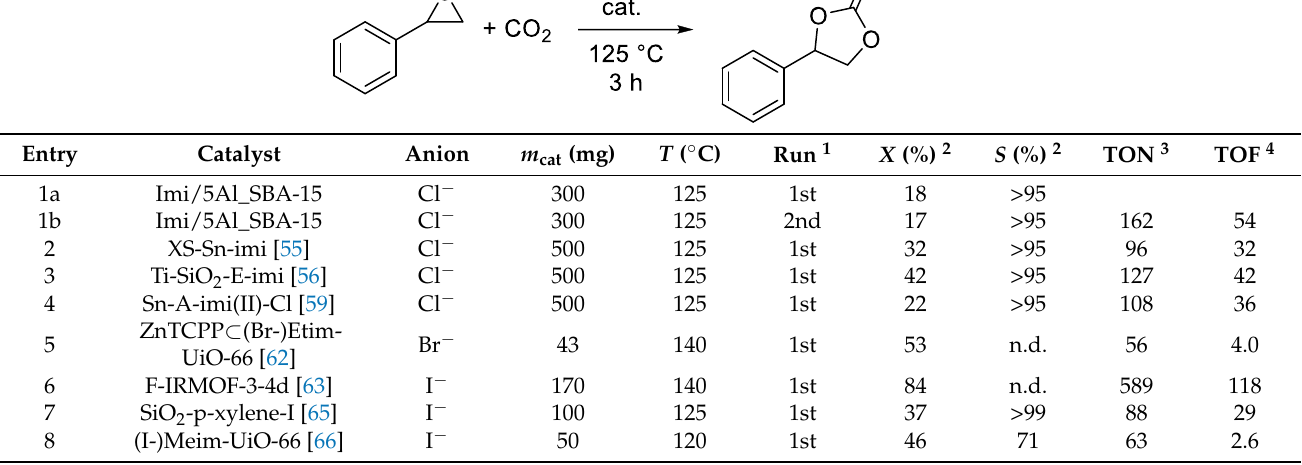
Table 4. Catalytic results for styrene oxide conversion to the corresponding cyclic carbonate.